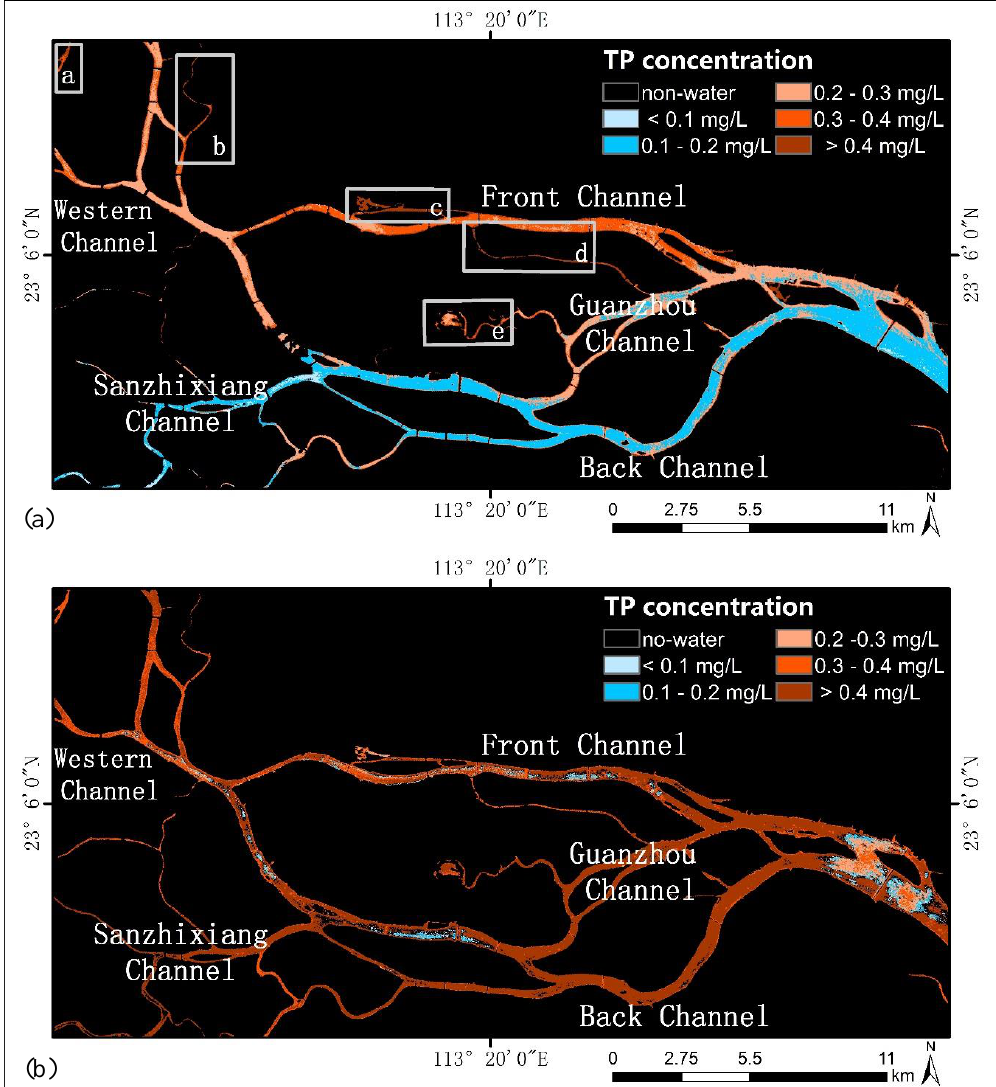
Figure 13. Remote sensing retrieval results of TP concentration in the Pearl River channels: ( a ) Imaging date: 2015-08-07, ( b ) Imaging date: 2015-10-24.